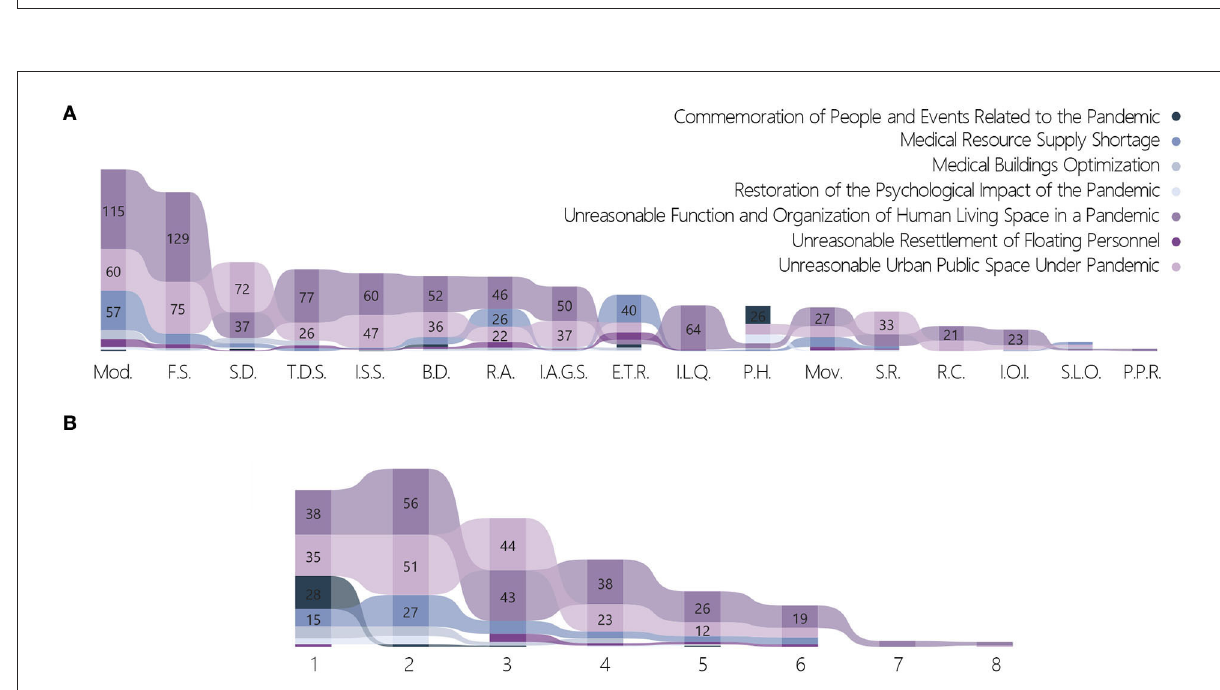
FIGURE11 Cross-tabulation results with target problem. (A) Target problem and strategies. (B) Target problem and target problem label